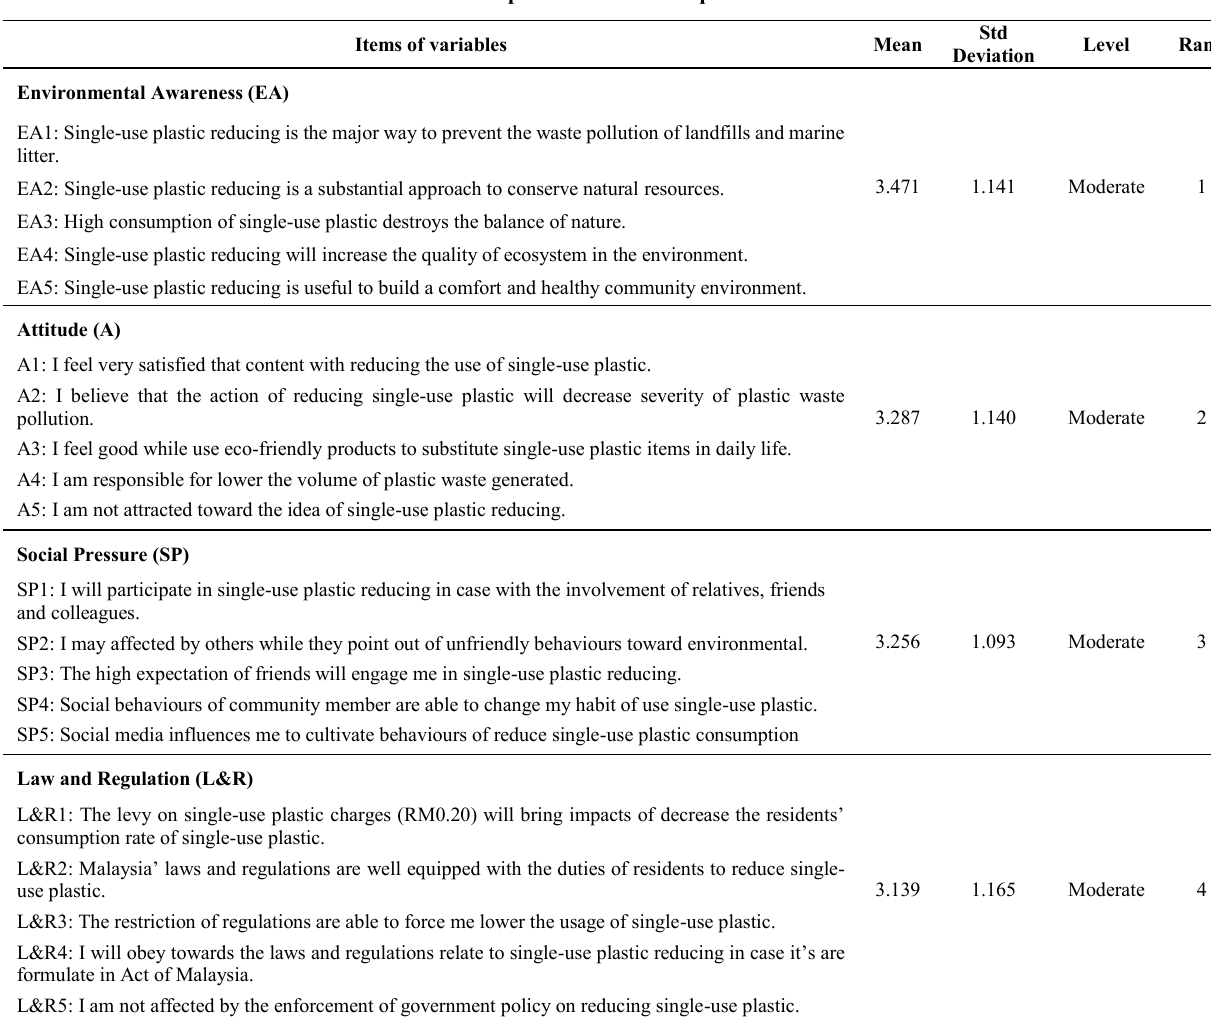
Table 2. Descriptive result for Independent